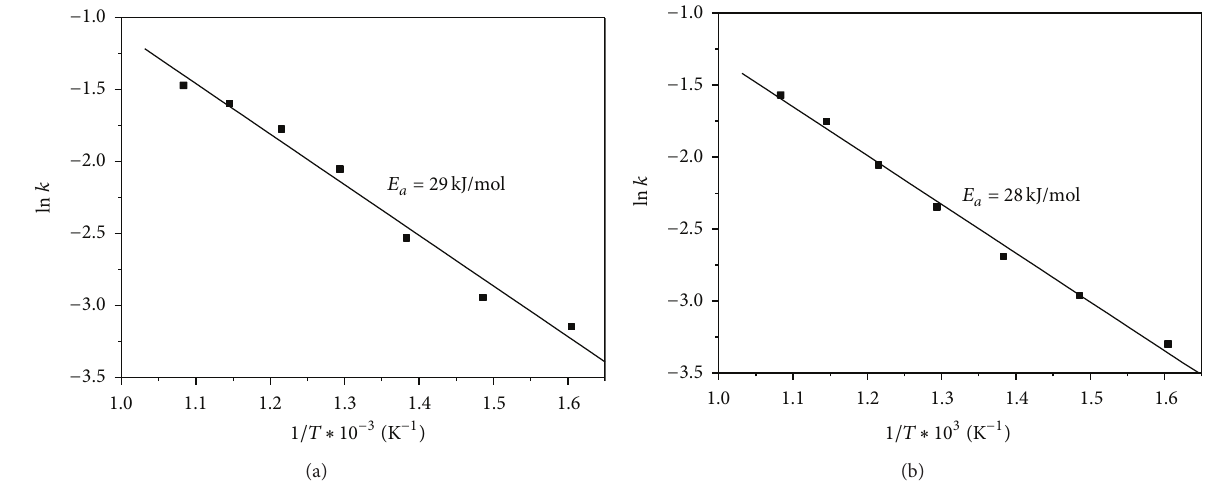
Figure 4: Arrhenius plot for the reduction of (a) NiO and (b) NiCl 2 by hydrogen during the induction period.